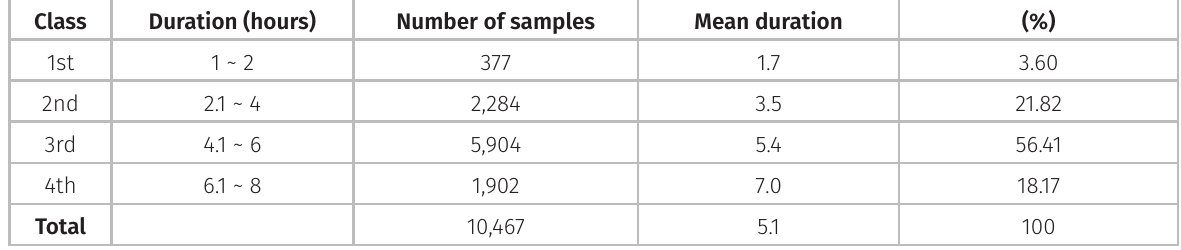
Table I. Duration of the trawls conducted by the piramutaba ( Brachyplatystoma vaillantii ) trawler fleet operating off the north coast of Brazil, between 2008 and 2011, based on the onboard maps of the fishing